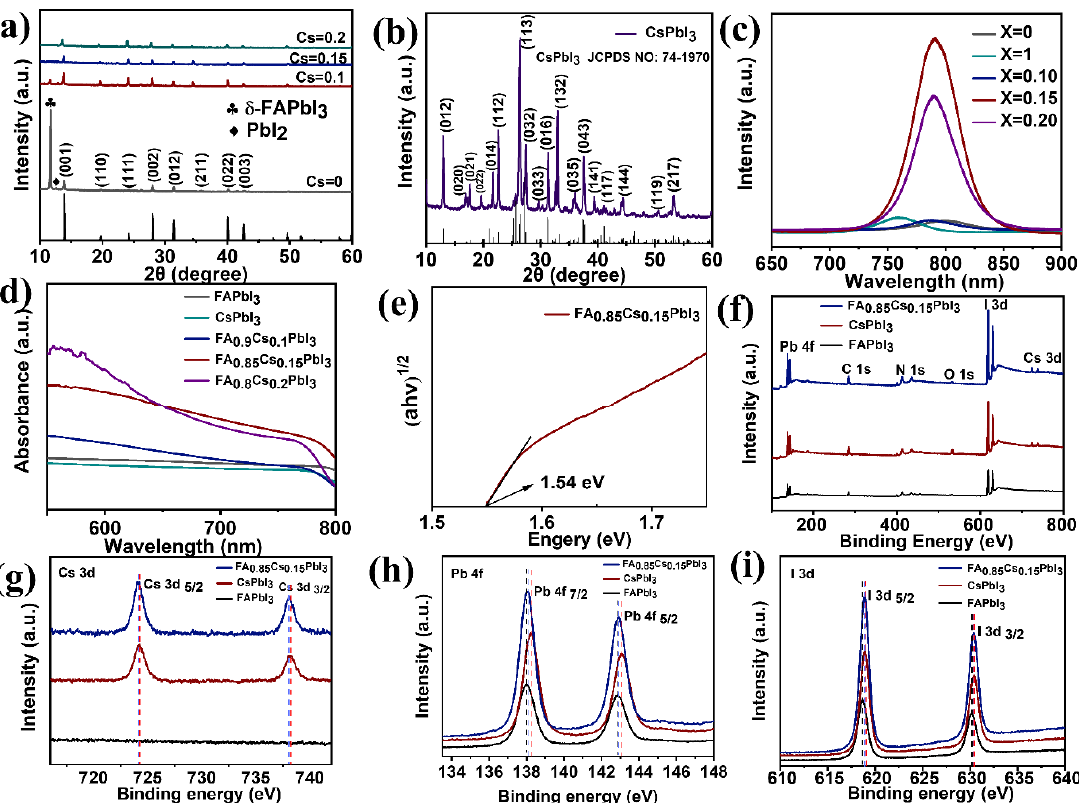
Figure 3. ( a ) XRD pa tt erns of the FA 1 − x Cs x PbI 3 thin fi lm ( x = 0, 0.10, 0.15, and 0.20, respectively); ( b ) XRD pa tt erns of the CsPbI 3 thin fi lm; ( c ) photoluminescence (PL) spectra of FA 1 − x Cs x PbI 3 thin fi lm ( x = 0, 1, 0.10, 0.15, and 0.20, respectively); ( d ) the UV-vis absorbance spectra of FA 1 − x Cs x PbI 3 thin fi lm ( x = 0, 1, 0.10, 0.15, and 0.20, respectively); ( e ) the relationship between ( α hv ) 1/2 and photon energy of FA 0.85 Cs 0.15 PbI 3 thin fi lm; ( f ) XPS spectra of FAPbI 3 (black), CsPbI 3 (red) and FA 0.85 Cs 0.15 PbI 3 (blue) thin fi lm; ( g – i ) the corresponding Cs 3d, Pb 4f and I 3d spectra, respectively. Table 1. The XPS data comparison of FAPbI 3 , CsPbI 3 , and FA 0.85 Cs 0.15 PbI 3 for Cs 3d, Pb 4f, and I 3d core levels.